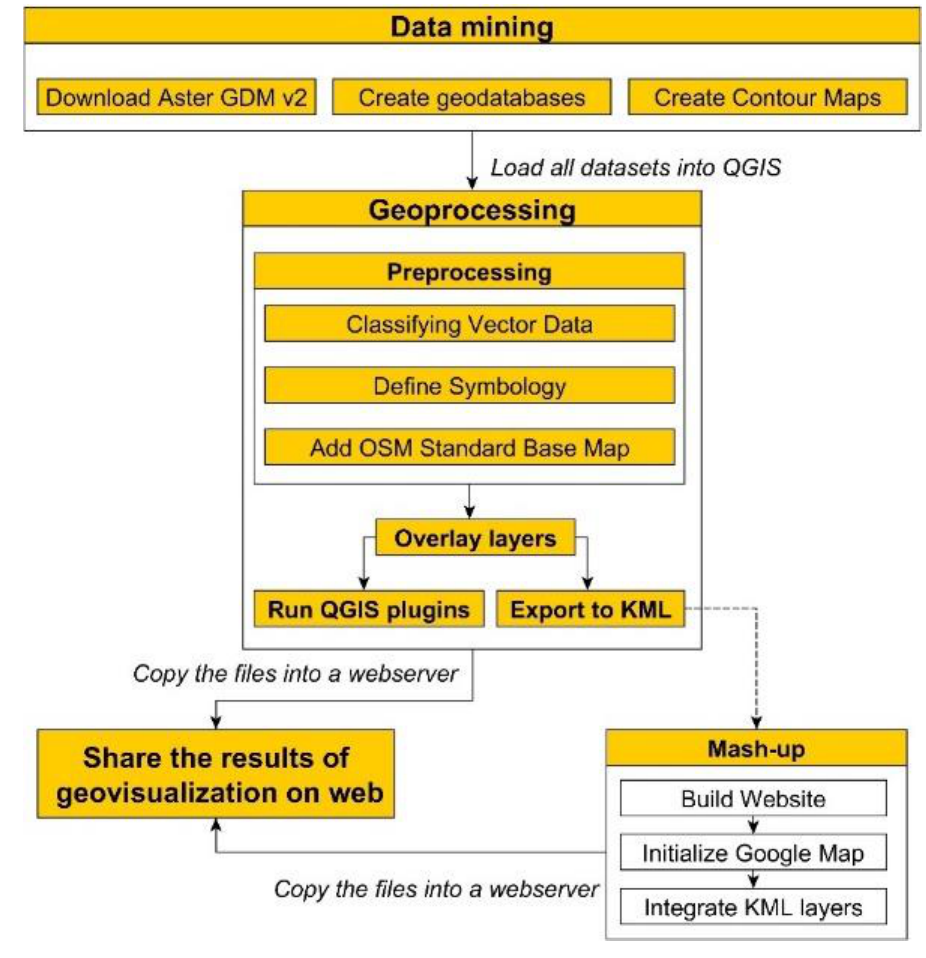
Figure 2. Process of geovisualization.